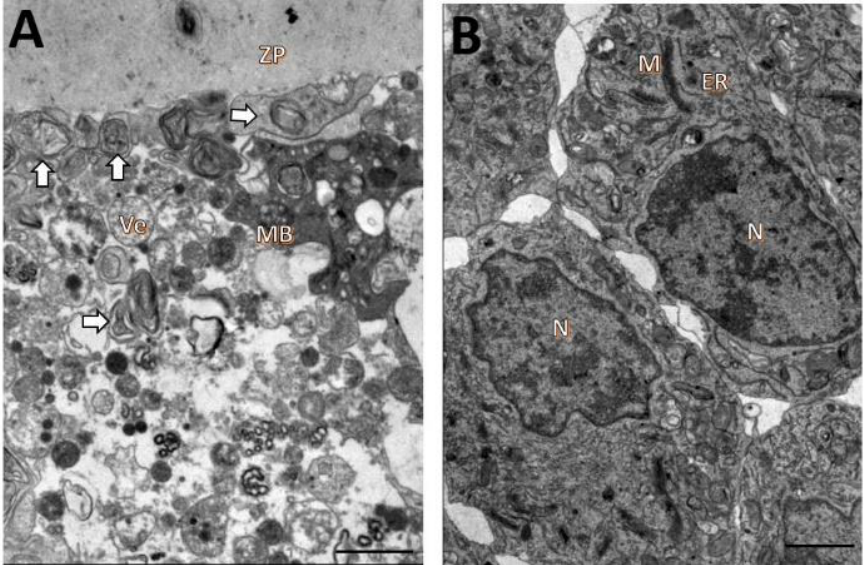
Figure 4. Ultrastructural characteristics of oocytes ( A ) and granulosa cells ( B ) from secondary follicles after 18 days of in vitro culturing in TCM 199 + supplemented with 1 mM NAC. Mitochondria (M), zona pellucida (ZP), nucleus (N), endoplasmic reticulum (ER), vesicles (Ve), multivesicular body (MB), degenerating organelles (arrows). Scale bar: 100 µm.